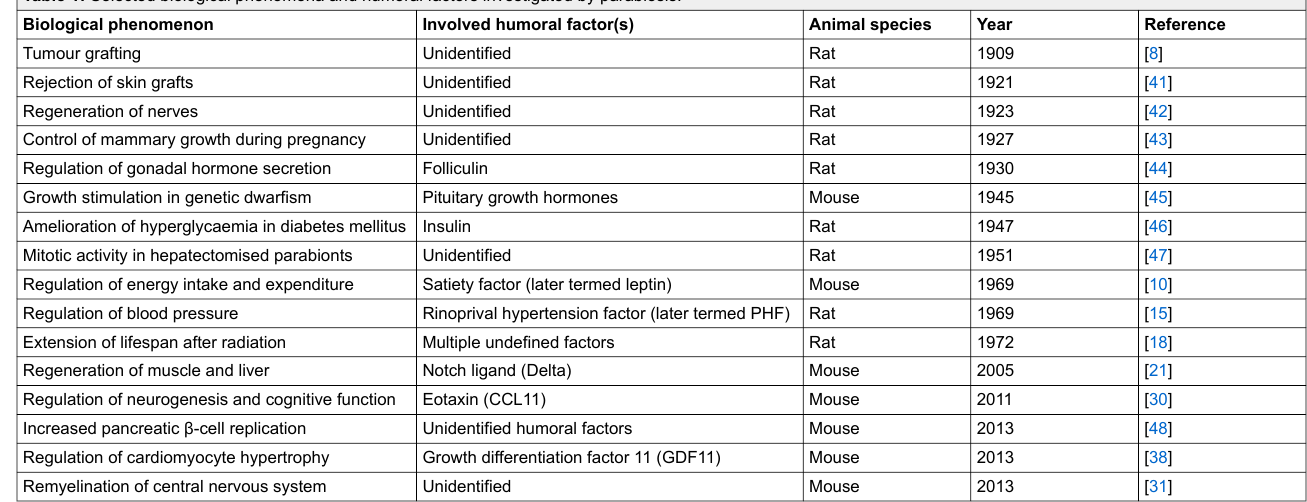
Table 1: Selected biological phenomena and humoral factors investigated by parabiosis. Biological